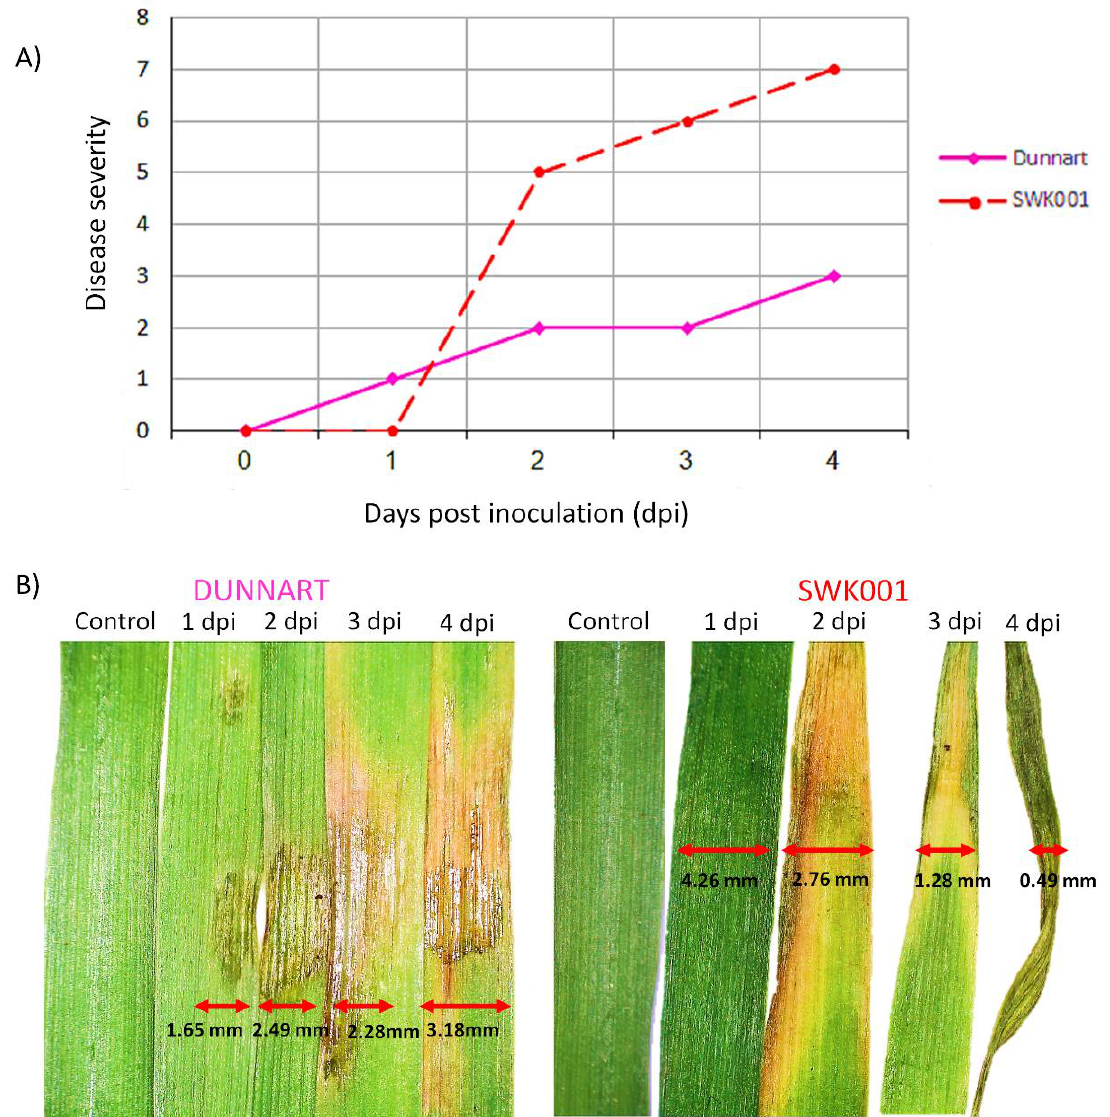
Figure 1. Disease severity rating and typical symptom development of oat cultivars responding to Pseudomonas syringae pv. coronafaciens infection over a period of 4 days post-inoculation (d.p.i.). ( A ) Disease severity scores for phenotypical symptom development in “Dunnart” (solid pink line) and “SWK001” (dashed red line) cultivars ranging from 0 = leaves are free of any visual symptoms to 8 = very severe wilting occurs (50% or more of leaves are yellow and wilted). ( B ) Following inoculation, the development of lesions on the “Dunnart” leaves were observed over time. Lesions started appearing from 1 d.p.i. and spread progressively over time. At 4 d.p.i. the lesions appear to cover a larger section of the leaf surface. In the “SWK001” cultivar severe symptoms can be seen as the leaves start yellowing from the tips at 2 d.p.i. and become more severe over time. At 4 d.p.i. the leaves start dying and appear shrivelled.